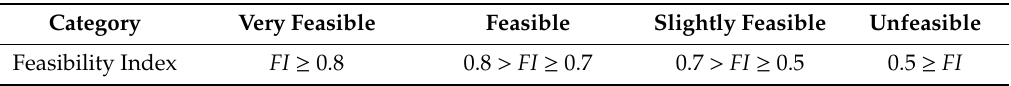
Table 6. Area categorization using the feasibility index.